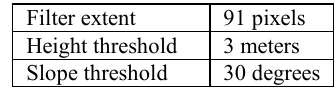
Table 1. Parameters used in all tests.